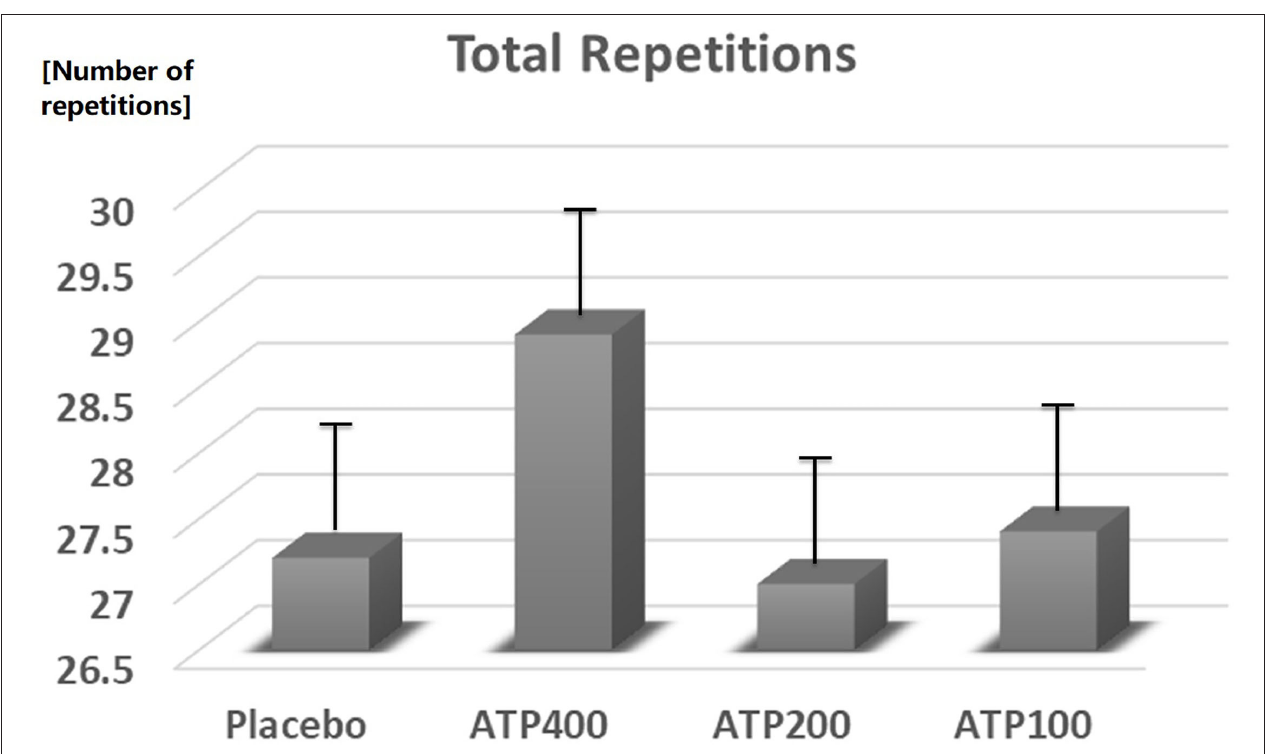
FIGURE 4 | ATP supplementation did not statistically significant increase the total number of repetitions. Data are expressed as Least Squares-Means ± standard error.